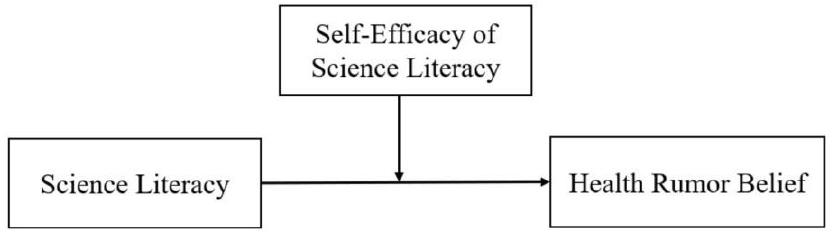
Figure 1. Hypothesized model of self-efficacy, science literacy, and